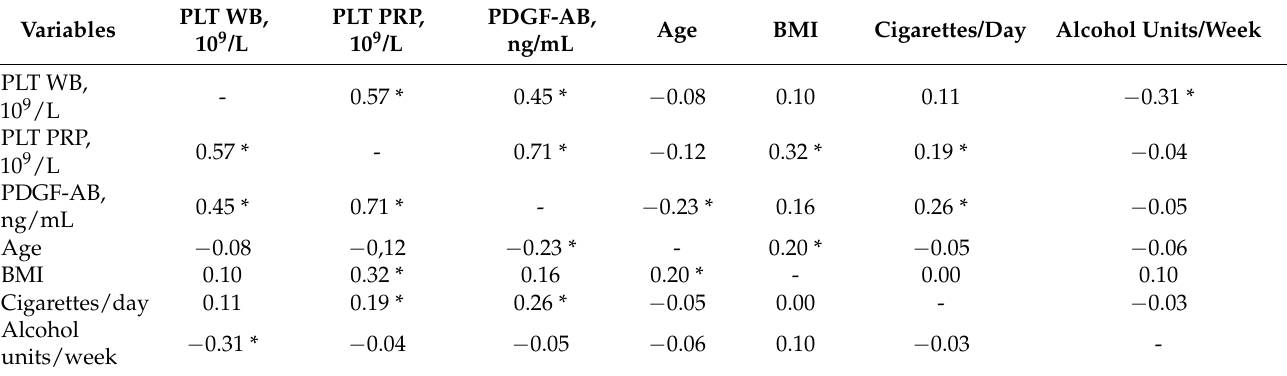
Table 2. Spearman’s rank correlation coefficients (r s ) between factors influencing platelets and PDGF-AB